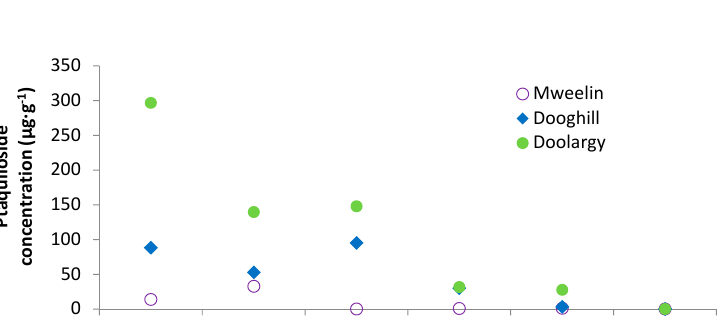
Figure 4. Trends in average ptaquiloside concentrations in bracken fronds from Mweelin Well, Dooghill and Doolargy.